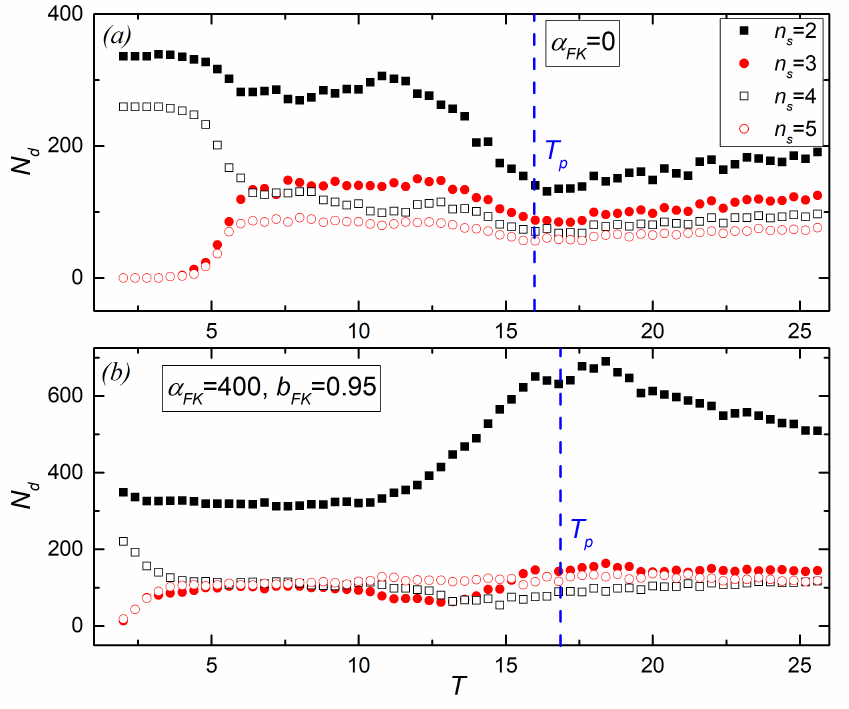
Figure 5. Number of magnetic domains with a length of 2 to 5 spins depending on temperature (unit: J FM / k B ) ( a ) without the substrate potential and ( b ) in the presence of the substrate potential with an 0 amplitude of 400 and a period of